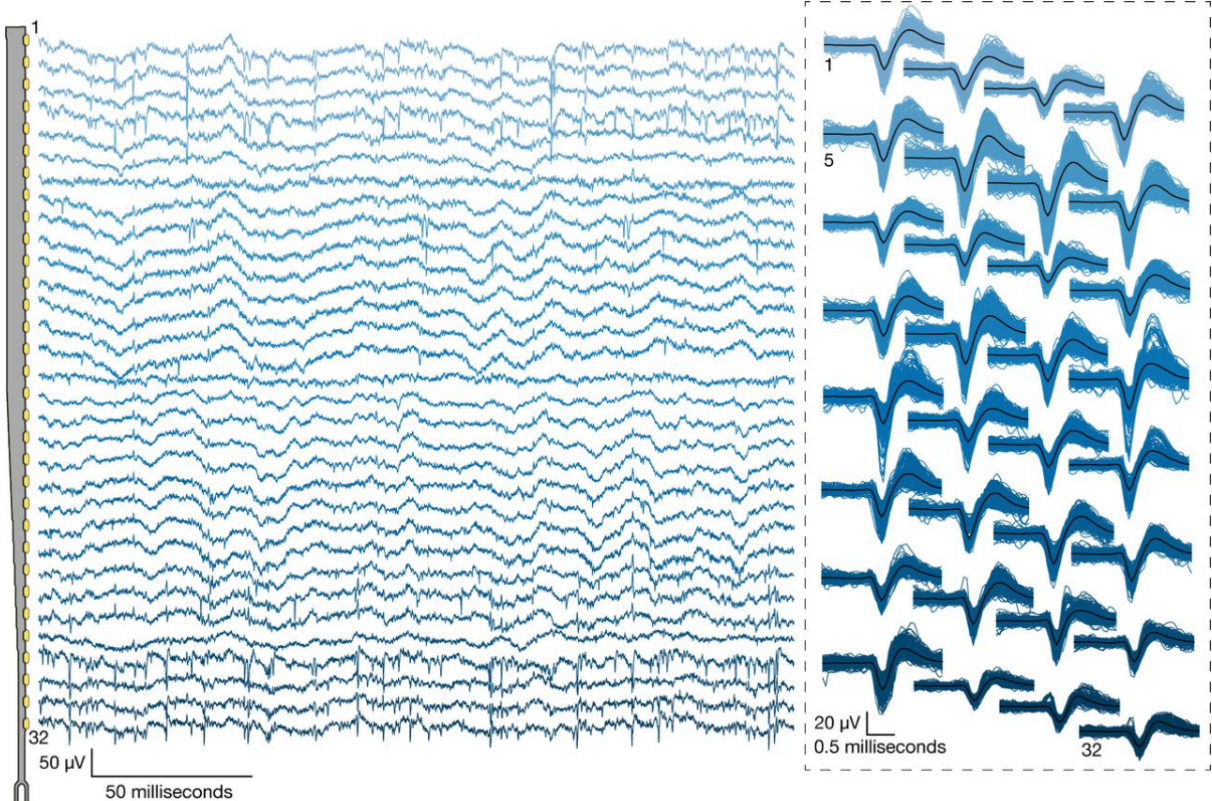
Figure 7. The broadband signals recorded from a representative thread. Left: Broadband neural signals (unfiltered) simultaneously acquired from a single thread (32 channels) implanted in rat cerebral cortex. Each channel (row) corresponds to an electrode site on the thread (schematic at left; sites spaced by 50 μm). Spikes and local field potentials are readily apparent. Right: Putative waveforms (unsorted); numbers indicate channel location on thread. Mean waveform is shown in